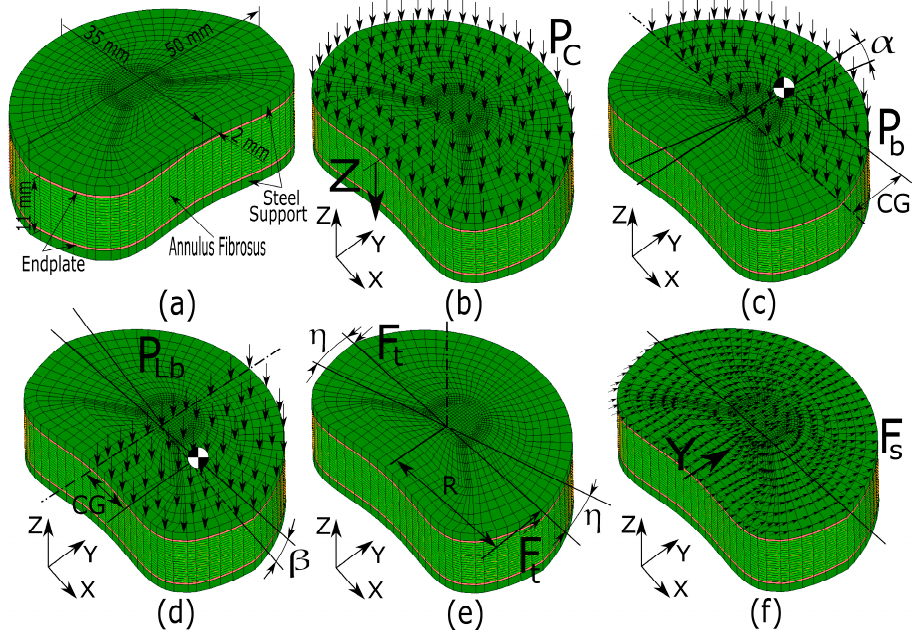
Figure 6. Intervertebral disc (IVD) dimensions and boundary conditions necessary for the standard test: ( a ) IVD dimensions; ( b ) compression load; ( c ) flexion load; ( d ) lateral bending load; ( e ) torsion load; and ( f ) shear load.